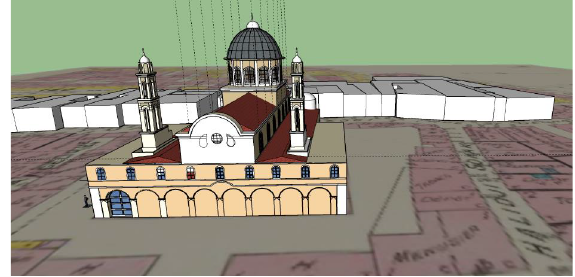
Figure 2. Virtual reconstruction process St. George